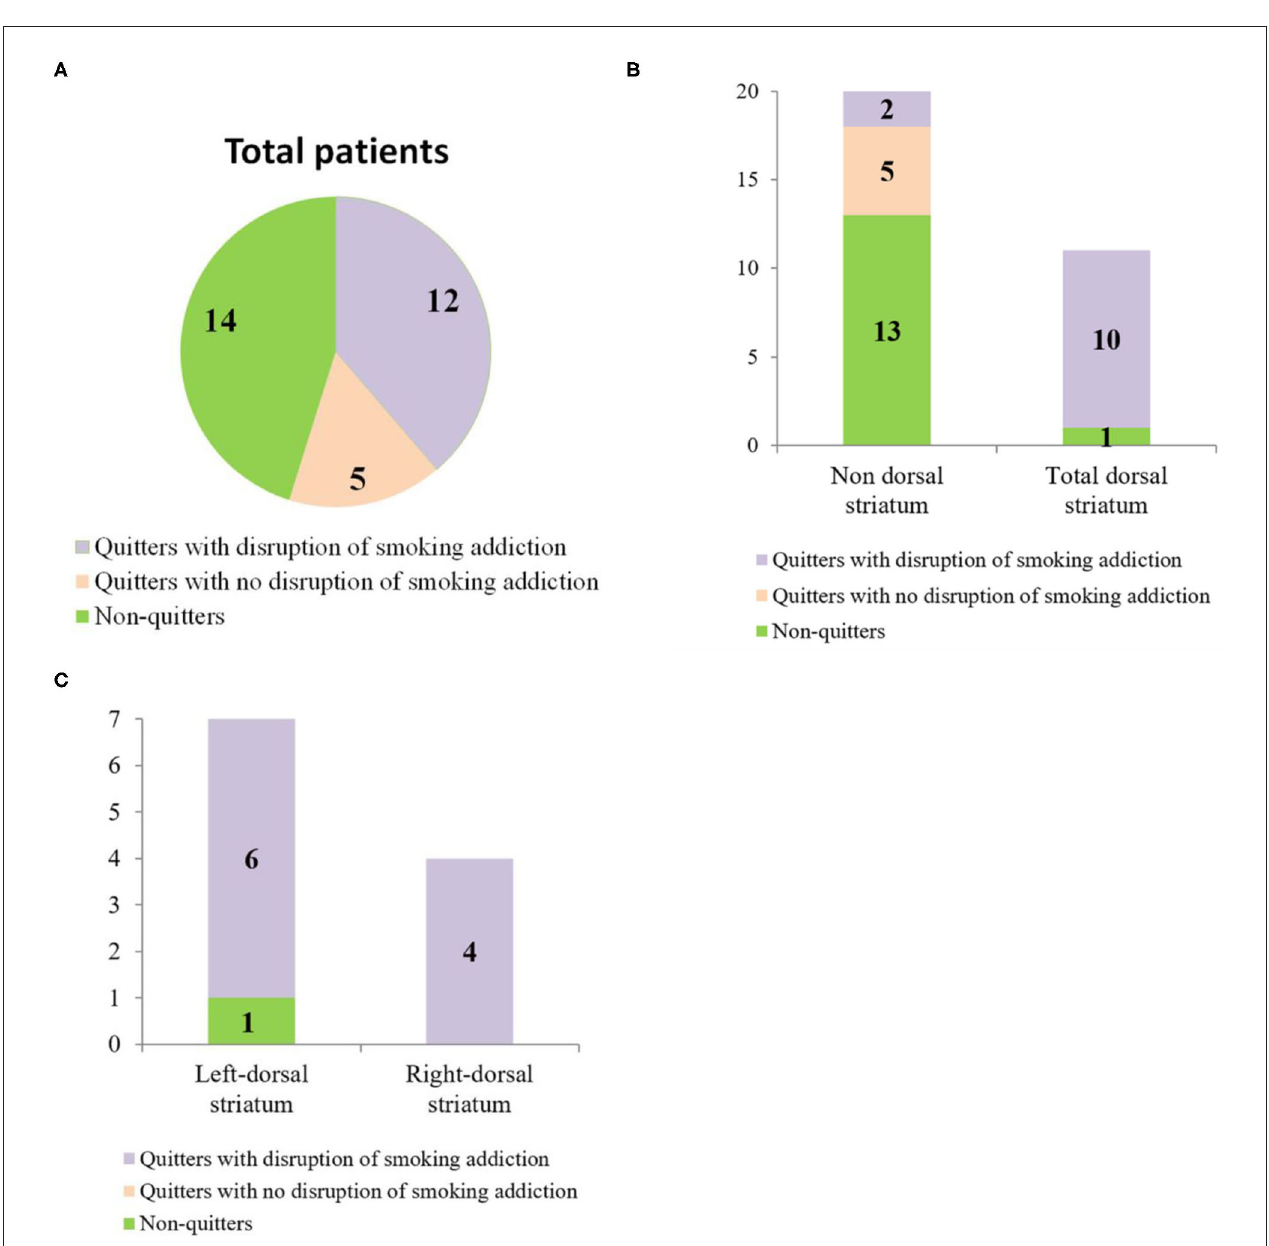
FIGURE 3 | (A) Pie chart showing the behavioral classification of total patients. (B) Bar graph showing the number of patients in each anatomical group who fell into each of the behavioral categories. (C) Bar graph showing the number of patients with left dorsal striatum damage and right dorsal striatum damage who fell into each of the behavioral categories.